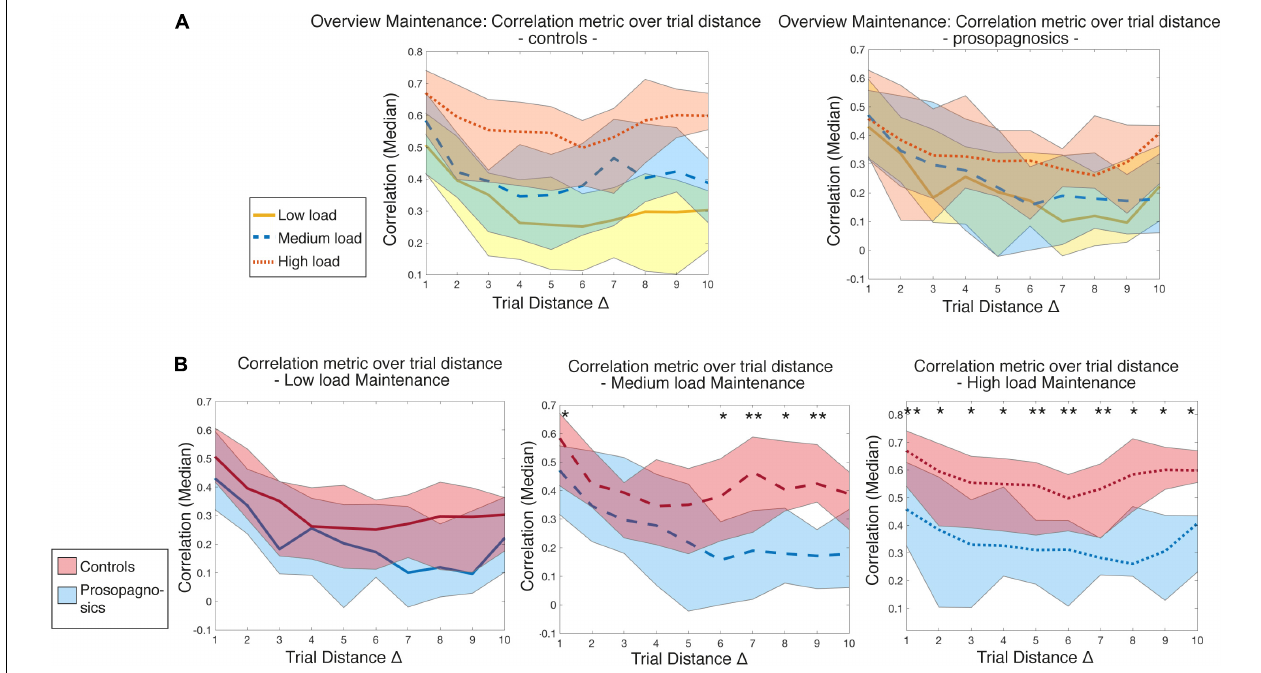
FIGURE 7 | Illustration of correlation metric over trial distance with (A) all memory conditions for controls vs. prosopagnosic subjects and (B) low, medium, and high load conditions with statistical comparison between controls and prosopagnosics for maintenance phase. Trial distances are statistically compared for each (cid:49) of each memory load condition between control and prosopagnosic subjects until (cid:49) = 10 via Mann-Whitney- U -test and Bonferroni-Holm-correction *, ( p < 0.05), ** ( p < 0.01). The colored areas represent the range between the 10% and 90% percentile of the specific diagonal entry